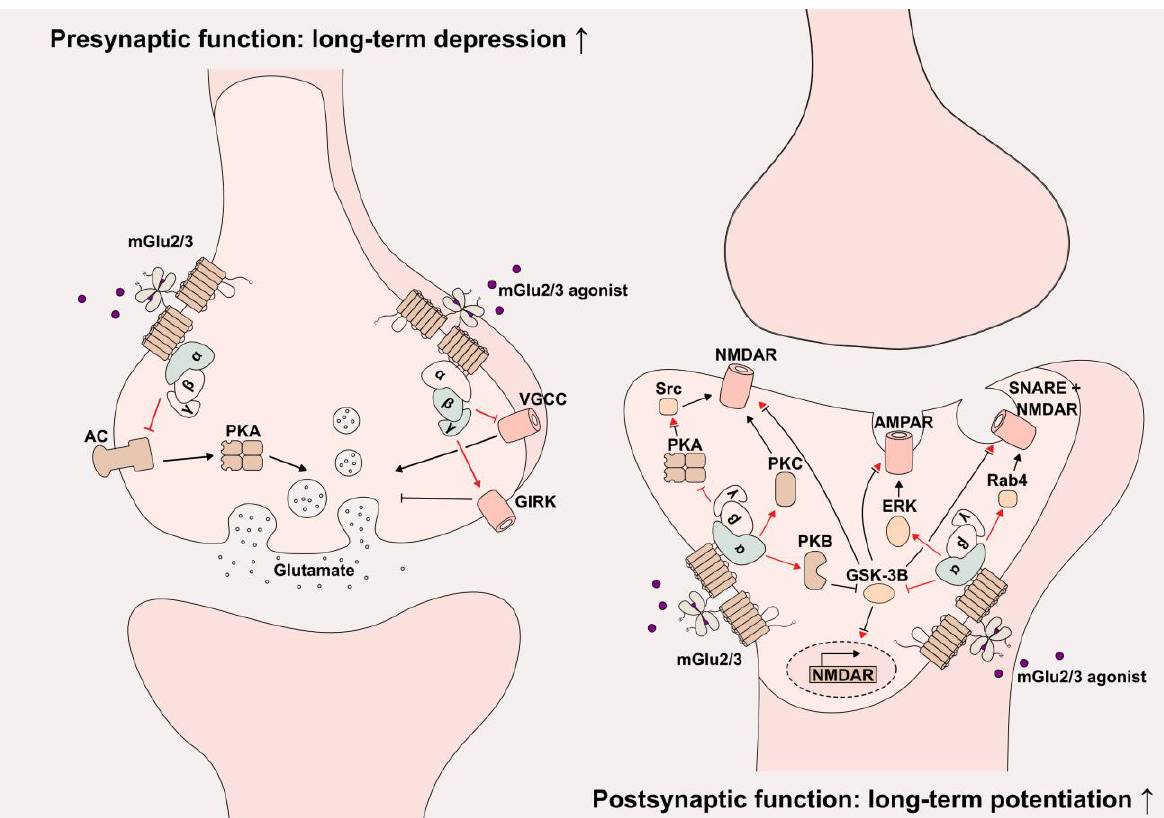
Figure 1. Molecular mechanisms of presynaptic and postsynaptic mGlu2/3 activation. Presynaptic (left) and postsynaptic (right) mGlu2 activation induces long-term depression and long-term poten- tiation, respectively. The relevant signaling cascades are displayed. Red indicates direct G-protein signaling consequences; red inhibitory arrow indicates second inhibition in the respective path. AC: Adenylyl c yclase, AMPAR: α -amino-3-hydroxy-5-methyl-4-isoxazolepropionic acid receptor, ERK: Extracellular signal-regulated kinases, GIRK: G protein-coupled inward rectifying potassium chan- nels, GSK-3B: Glycogen synthase kinase-3 beta, NMDAR: N-methyl-D-aspartate Receptor, PKA: Protein kinase A, PKB: Protein kinase B, PKC: Protein kinase C, Rab4: Ras-related protein Rab-4, Src: Proto-oncogene tyrosine – protein kinase Src and VGCC: Voltage-gated calcium channels.